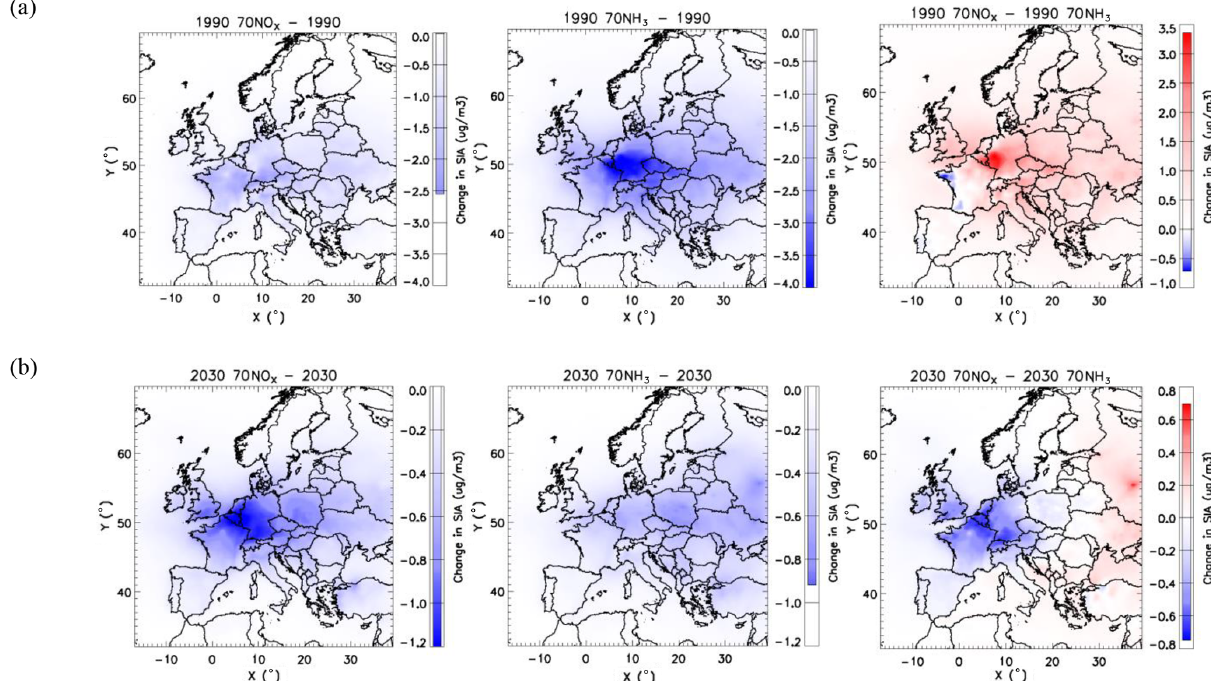
Figure 6. Change in SIA concentrations (µgm − 3 ) due to 30% reduction in NO x emissions (left), due to 30% reduction in NH 3 emissions (middle) and the difference between the two figures (right) (a) in 1990 and (b) in 2030_CLE. The red color in the right panels shows NH 3 -sensitive areas; the blue color shows NO x -sensitive